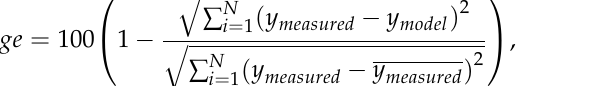
Table 2. General characteristics of each identification method.